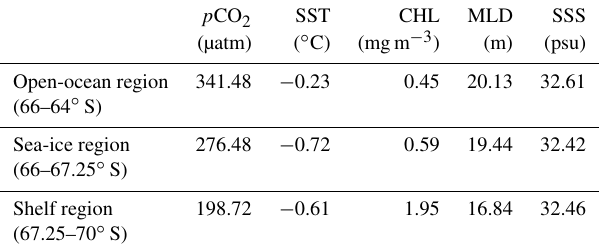
Table 2. The regional mean values of underway measurements in three subregions. p CO